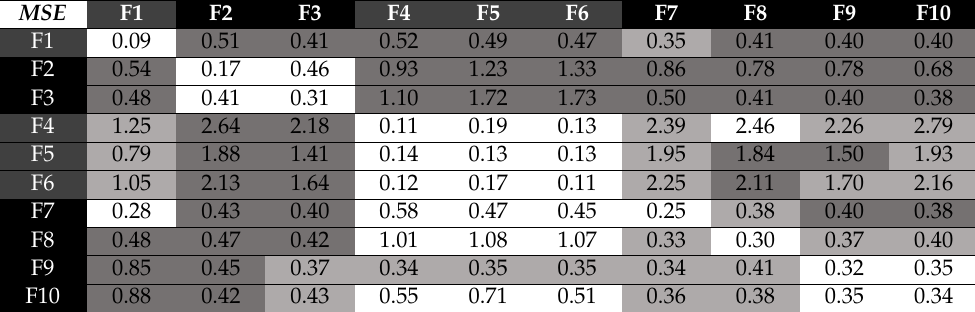
Table 5. MSE Values